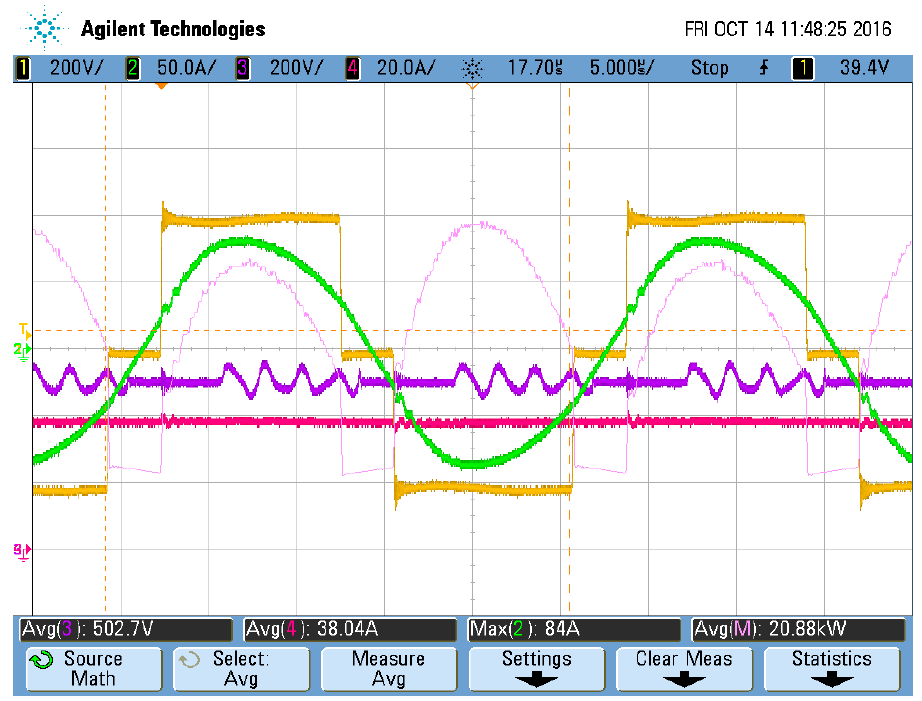
Figure 17. Experimental waveforms for V AB (yellow) and i PL (green), with V in = 400 V, V O = 500 V and P O = 20 kW.